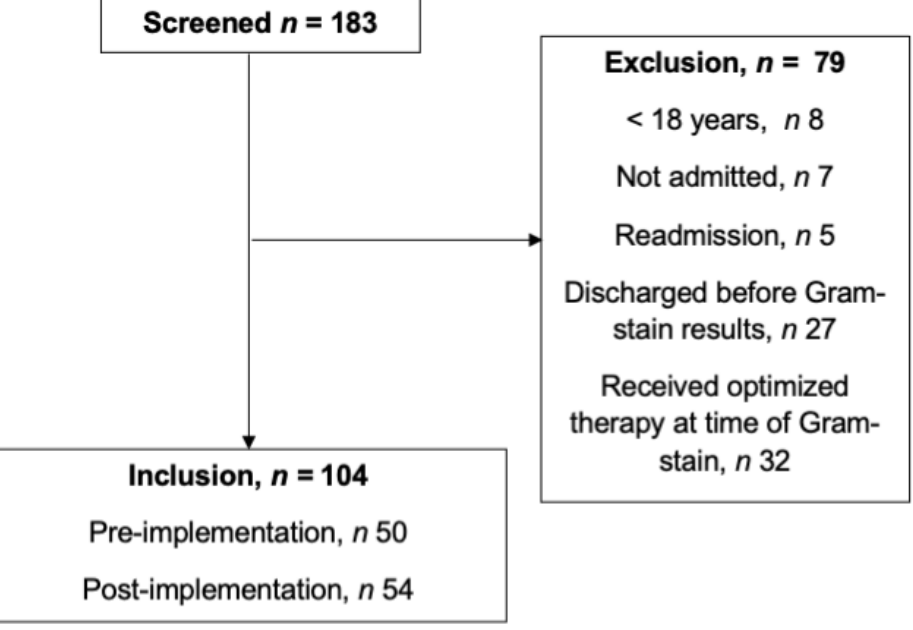
Figure 1. Cohort flow chart.